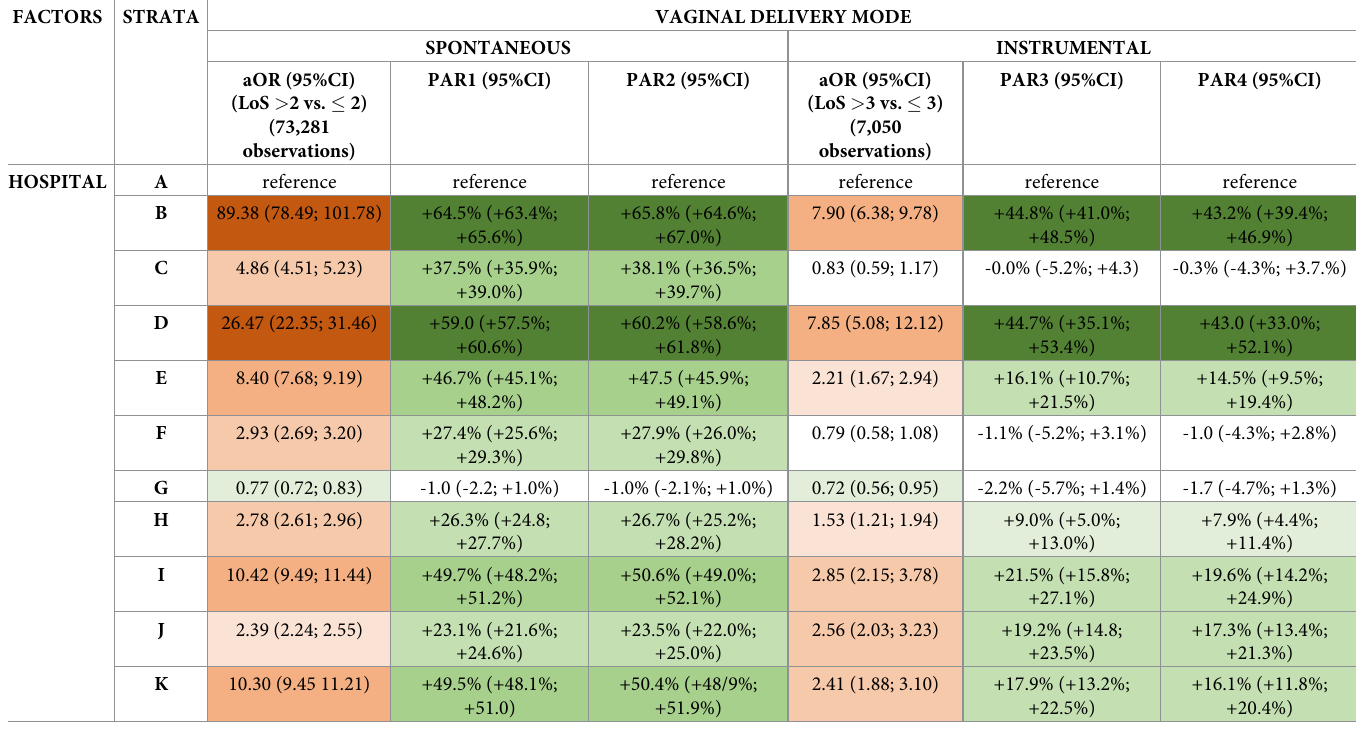
Table 5. Multiple logistic regression analysis. Outcome: length of hospital stay (LoS) longer than ED benchmarks (2 days for spontaneous vaginal deliveries; 3 days for instrumental vaginal deliveries). Effect estimates for hospital and calendar year adjusted for all other factors. Adjusted odds ratios (aOR � ) and population attributable risks (PAR1 $ , PAR2, �� PAR3, $ PAR4 �� ) with 95% confidence intervals (95%CI). NA = Not available; observations = complete (case analysis)